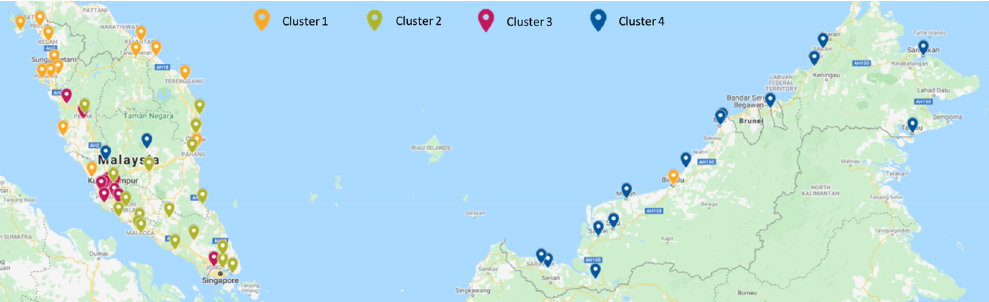
Figure 10. Air monitoring stations’ locations colored according to clusters for PM 10 daily average time series data with DTW and PAM as its clustering algorithm.